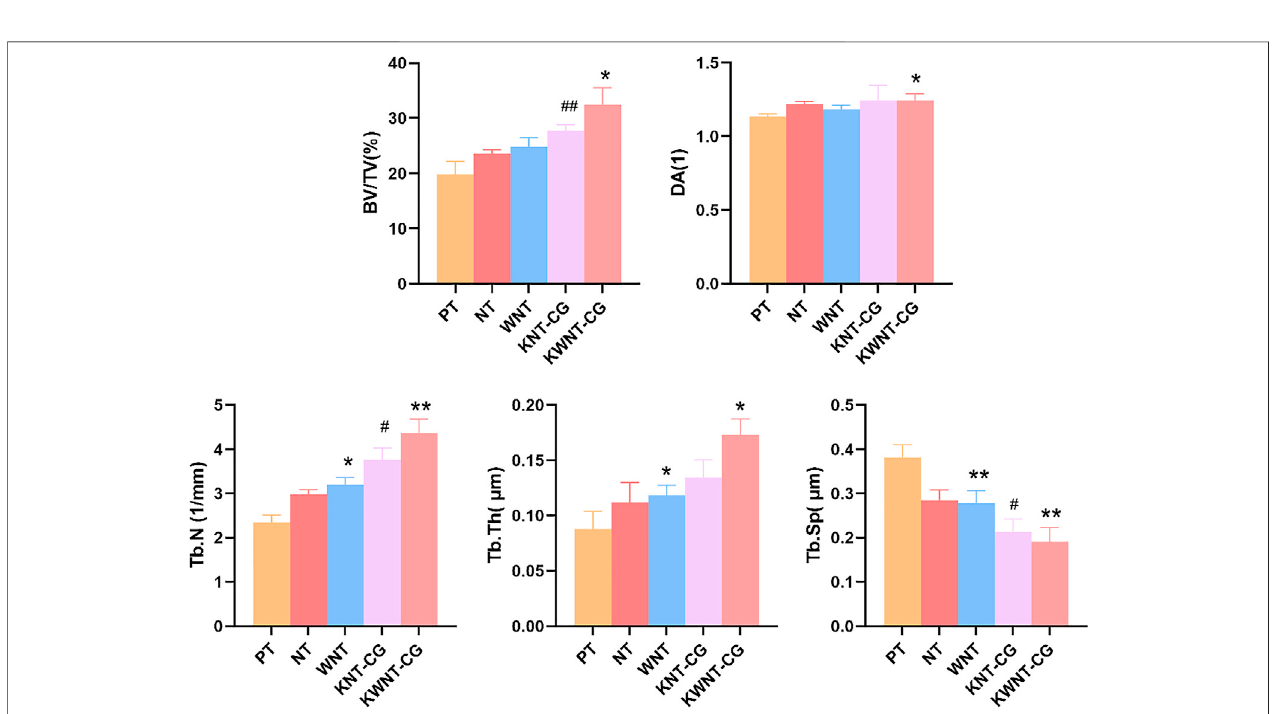
FIGURE 9 | Morphometric analysis of rat femur. BV/TV, bone volume per tissue volume; DA, degree of anisotropy; Tb.N, trabecular number; Tb.Th, trabecular thickness; Tb. Sp, trabecular sepacing. Bar graphs: Data are presented as mean ± SD. # represents comparison with NT group, ## p < 0.01, # p < 0.05; *represents comparison with PT group,** p < 0.01; * p <